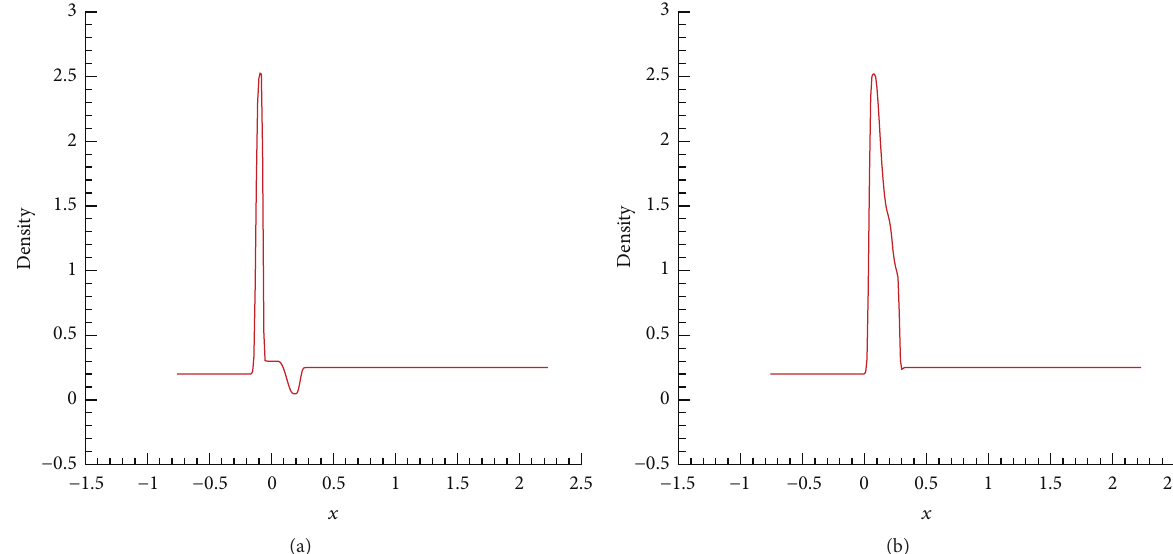
Figure 9: Numerical results of 𝜌 at 𝑡 = 0.8 (a) and 𝑡 = 2.9 (b) for Data 2.